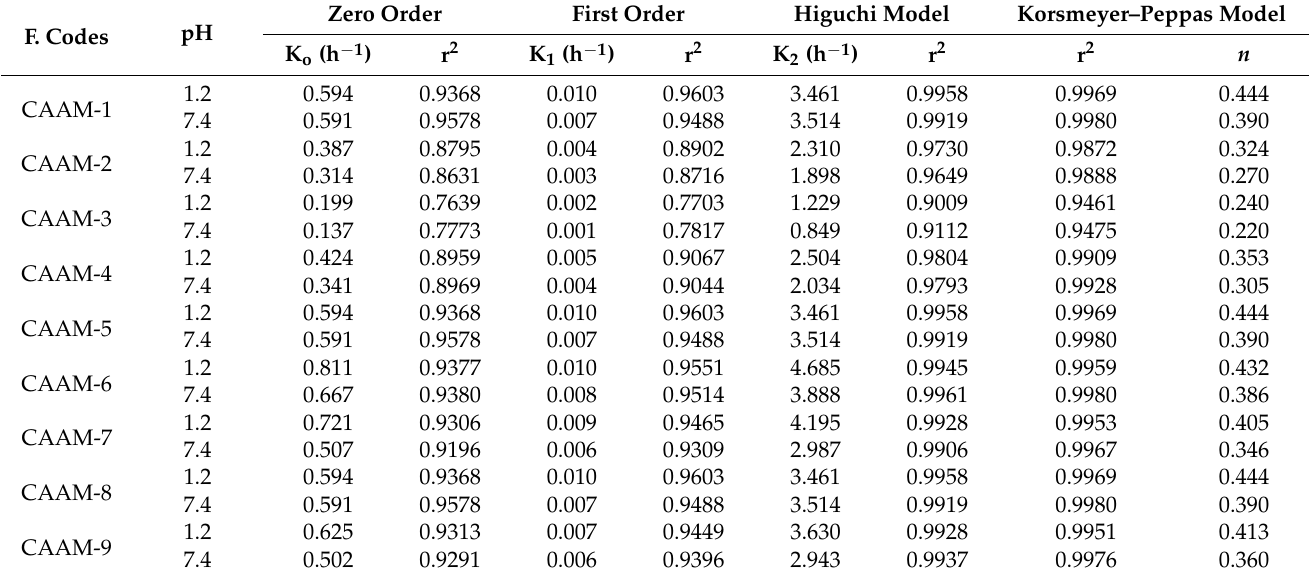
Table 2. Release kinetics of gallic acid from CS- g -AMPS hydrogels.